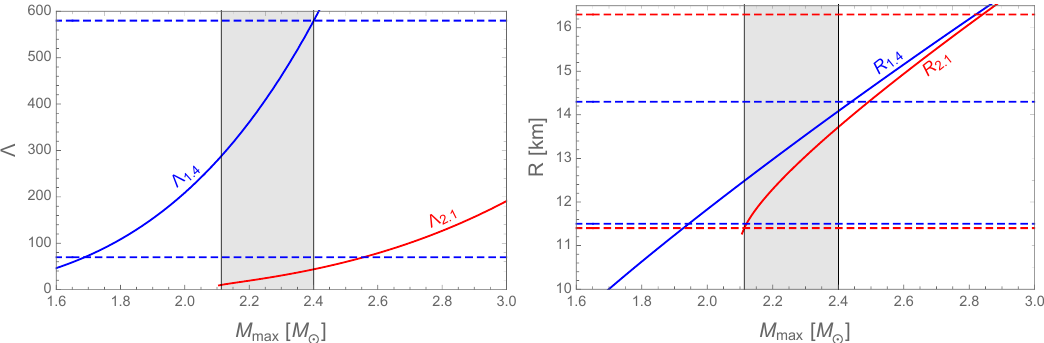
Figure 3: Tidal deformability Λ and radius R for a 1.4-solar-mass star (blue solid) and a 2.1-solar-mass star (red solid) as a function of the maximal mass M we have fixed the ’t Hooft coupling λ = 10 and the surface tension Σ = 1MeV / fm 2 , and different values of M are obtained by varying the second model parameter max M . The horizontal dashed lines indicate the astrophysical constraints for Λ KK R , and R . Beyond the shaded region at least one of the constraints is vio- 1.4 2.1 lated. As a consequence, for this particular value of the ’t Hooft coupling, we obtain (cid:174) 2.40 M 2.11 M (cid:12) (cid:174) M (cid:12) and new bounds for max (cid:174) 288 (cid:174) Λ 1.4